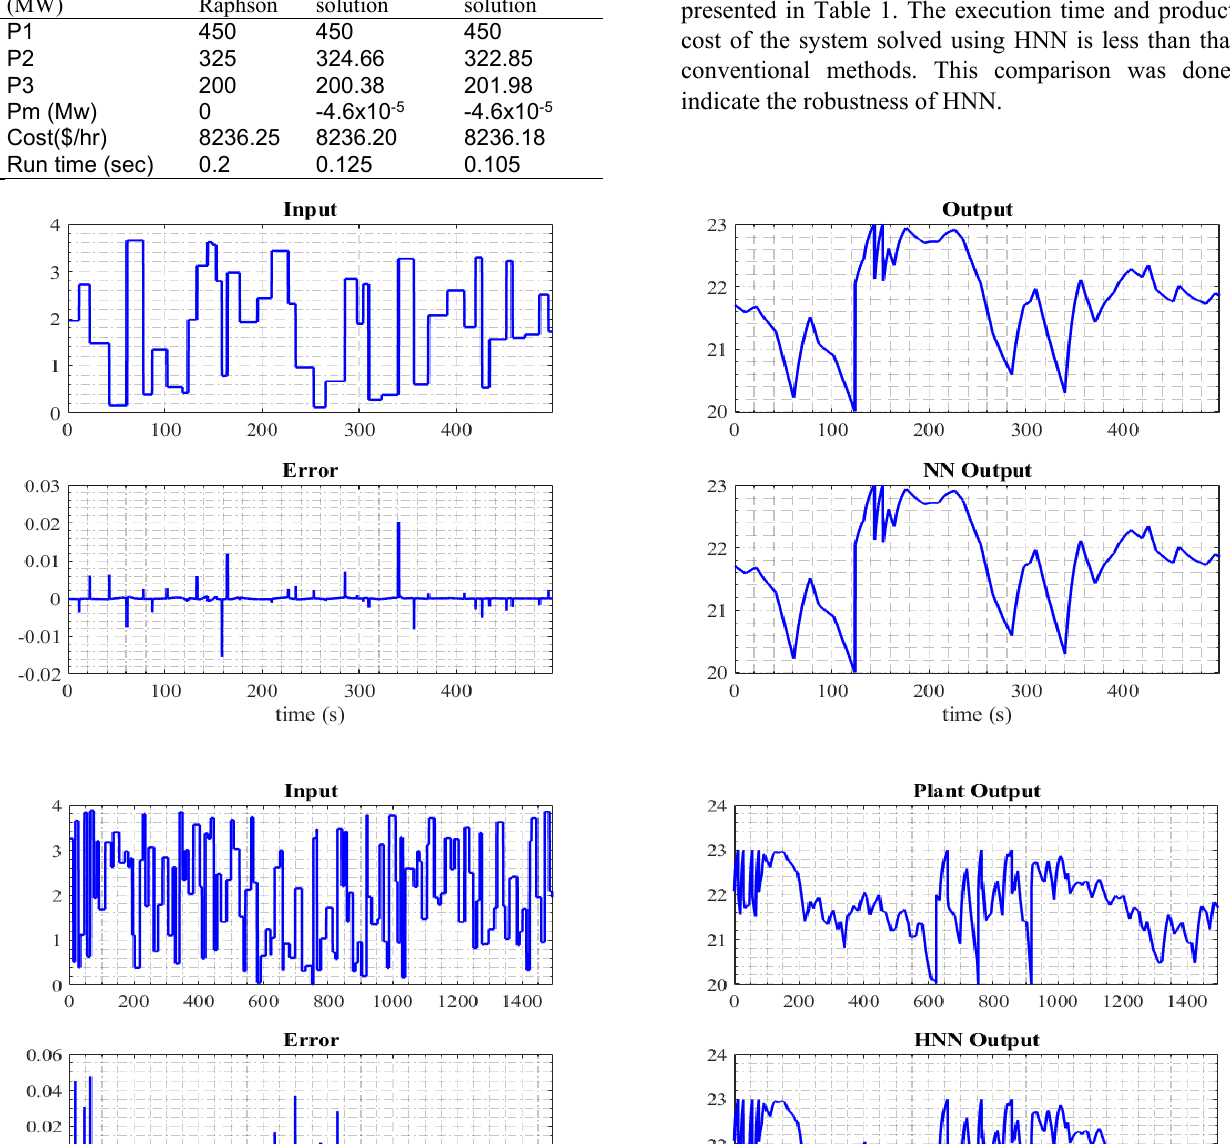
Table 1. Comparison table between solution methods